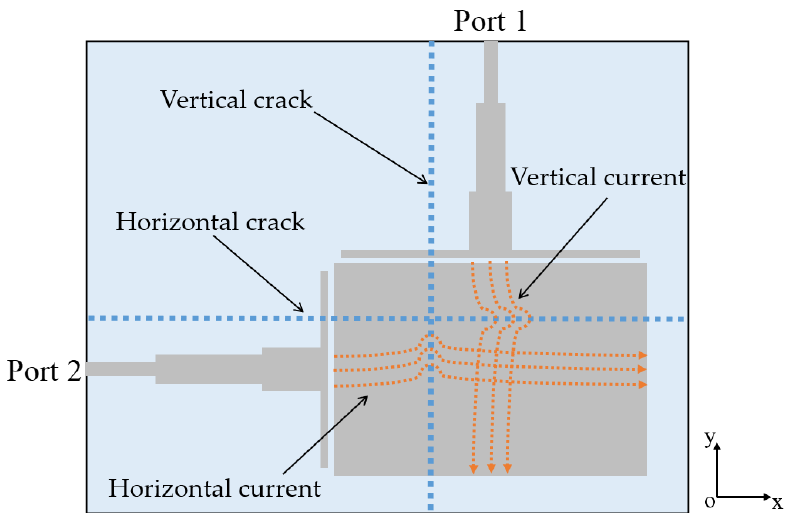
Figure 5. Crack direction detection of designed dual-port sensor.